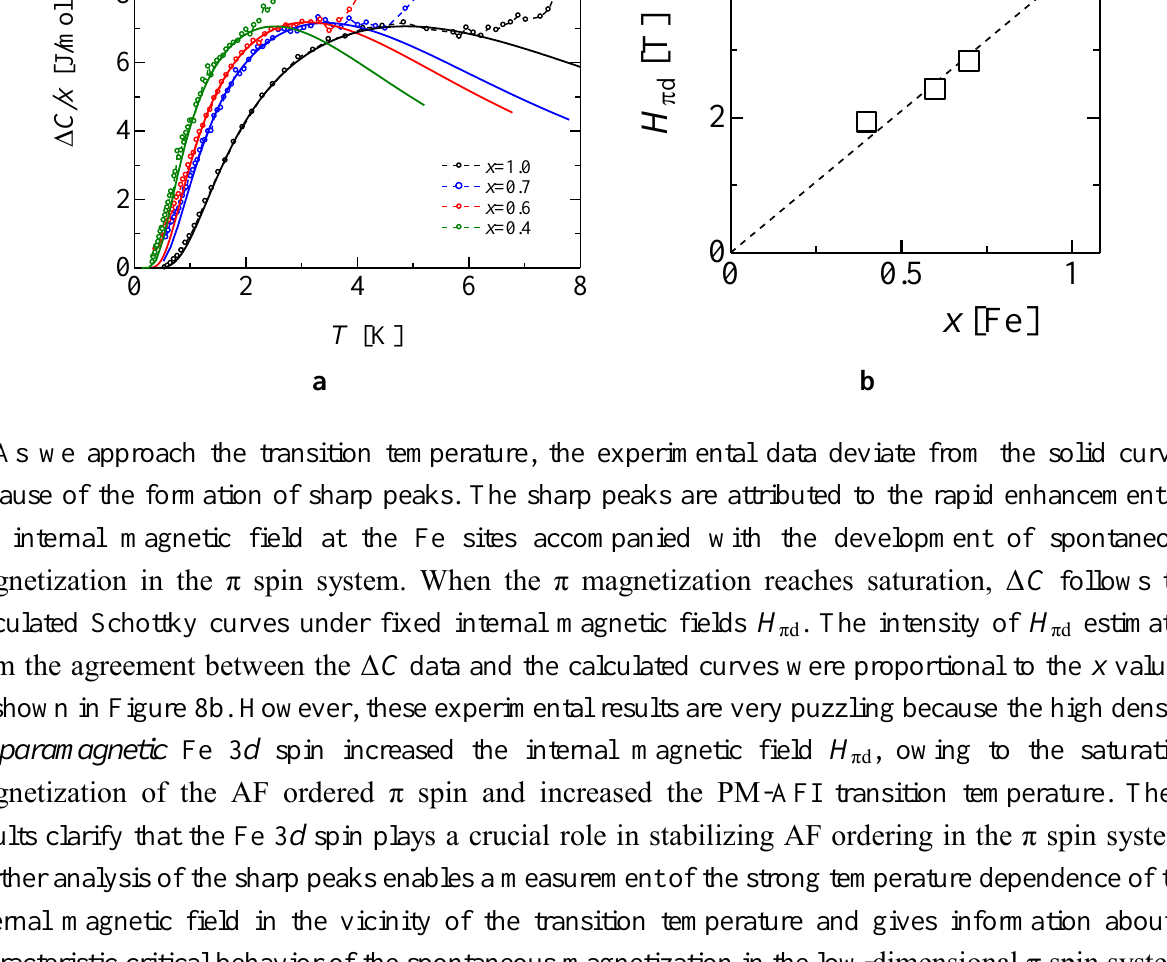
. The broad πd πd